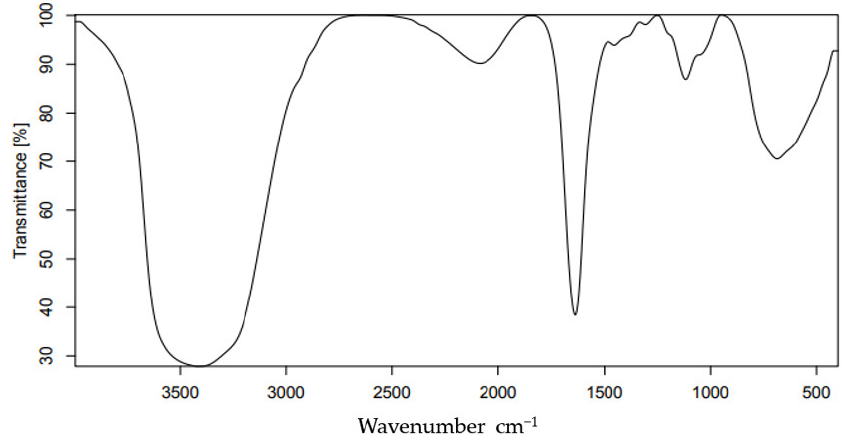
Figure 7. FTIR spectrum of 1.0% wt.% rGO-CuO nanoparticles at room temperature. Also, there was a high intense peak at 2750 cm − 1 due to the removal of oxygen- containing functional groups in the GO, and seven lower intensity peaks of 3425 cm − 1 , 1736 cm − 1 , 1621 cm − 1 , 1560 cm − 1 , 1396 cm − 1 , 1215 cm − 1 , and 1045 cm − 1 related to OH groups, the stretching of carboxylic acid groups, sp 2 -hybridized C groups remaining after oxidation, graphitic carbon, tertiary C-OH groups, epoxy symmetric ring deformation, and C-O stretching vibrations of alkoxy groups, respectively, in agreement with [87].